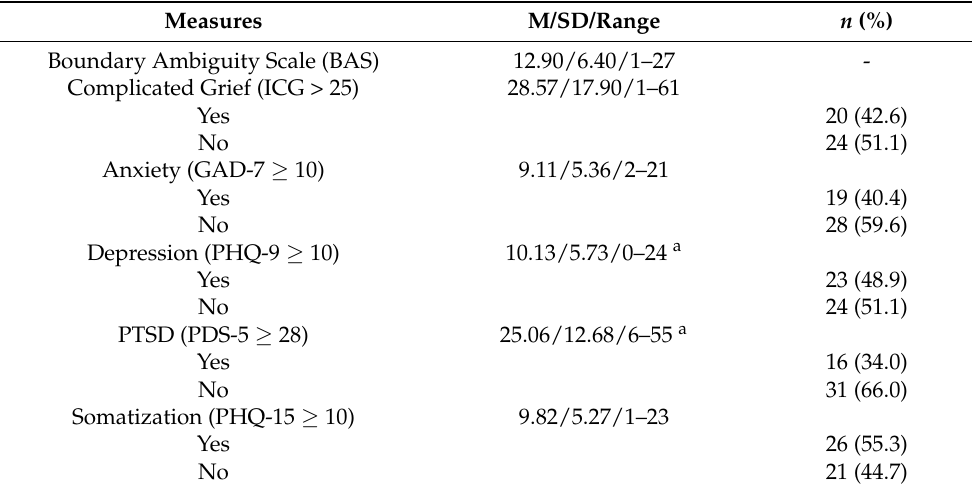
Table 4. Prevalence rates of mental health